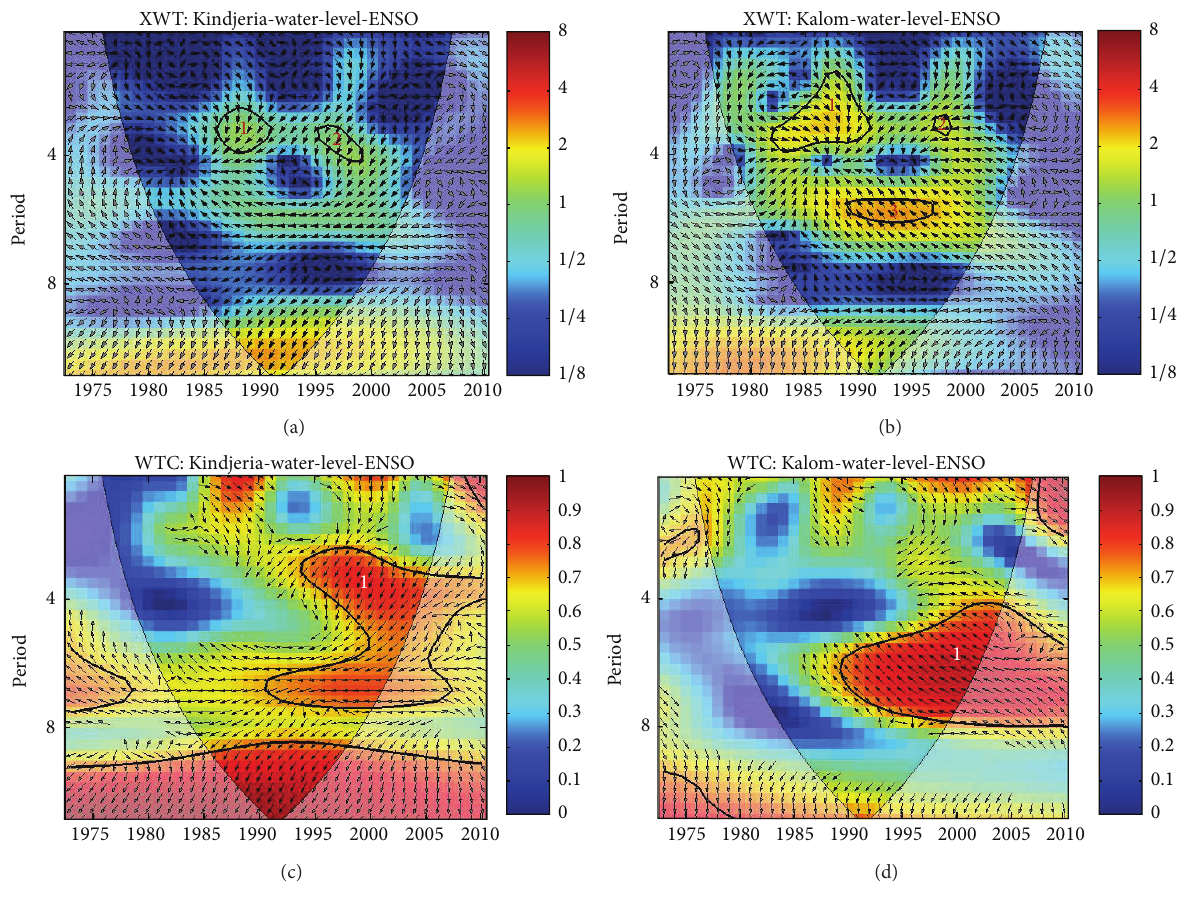
Figure 6: ENSO and lake level cross-wavelet spectra: (a) northern LCB; (b) southern LCB and wavelet coherence; (c) northern LCB; and (d) southern LCB. The thick contour enclosed regions are greater than 95% confidence for a red-noise process. The thin solid line indicates the “cone of influence,” where edge effects become